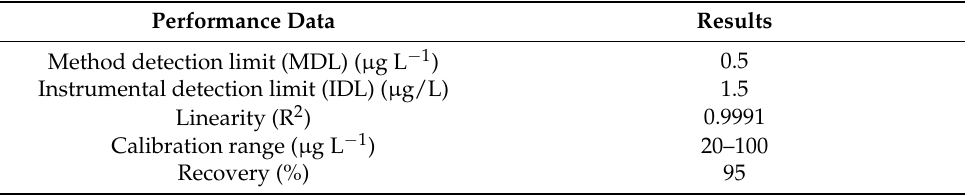
Table 2. Performance data of the analytical